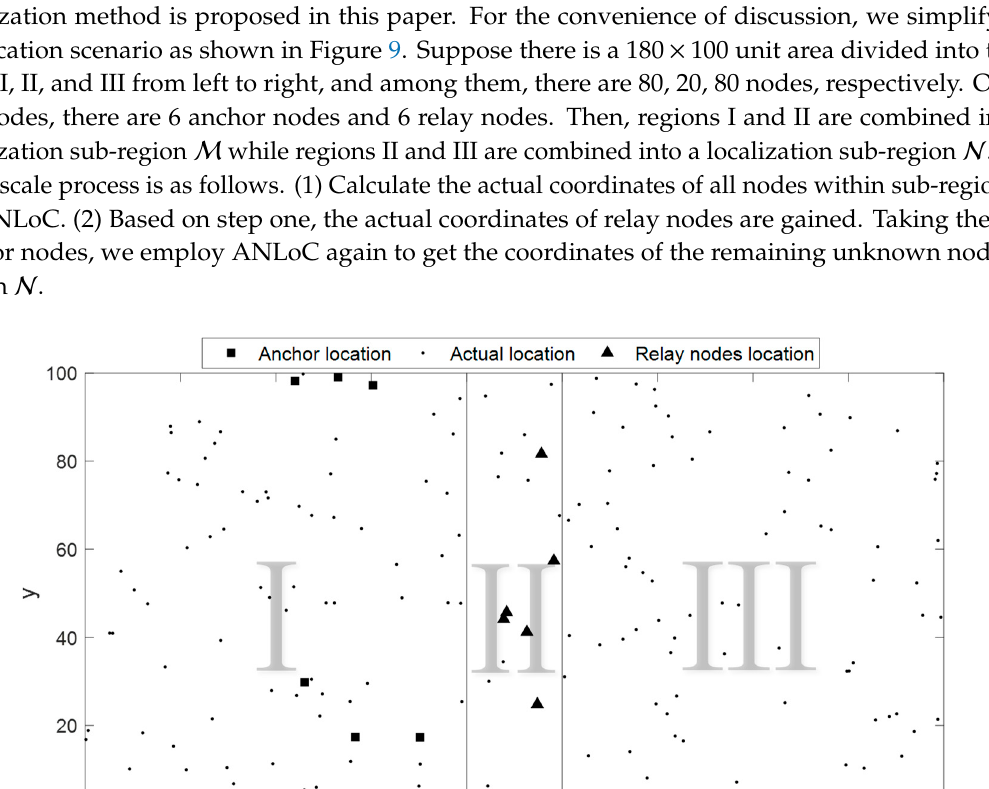
Figure 10. Localization results under large-scale scene scenario with complex noise and anomaly. 6. Conclusions In this paper, we aim to estimate node position of WSNs in complex environments. Considering that the coexistence of potential node anomaly and complex noise in practical applications, we propose a novel Anomaly-aware Node Localization (ANLoC) method to address this task. Specifically, the proposed ANLoC method is divided into two steps. First, a Robust ℓ (cid:2870),(cid:2869) -norm Regularized Matrix Decomposition (RRMD) model is designed to simultaneously detect node anomaly and impute the missing range measurements. Second, based on the imputed EDM matrix, all unknown nodes can be easily estimated by using the classic MDS method. The extensive experiments demonstrated our proposed ANLoC method consistently outperforms three state-of- the-art localization methods in terms of EDM recovery error, localization error, and anomaly recognition accuracy. Additionally, our proposed ANLoC method also can extend to a large-scale localization scenario. Future work will focus on extending our ANLoC approach to an incremental version, making it suitable for handling dynamic positioning of mobile sensor nodes.